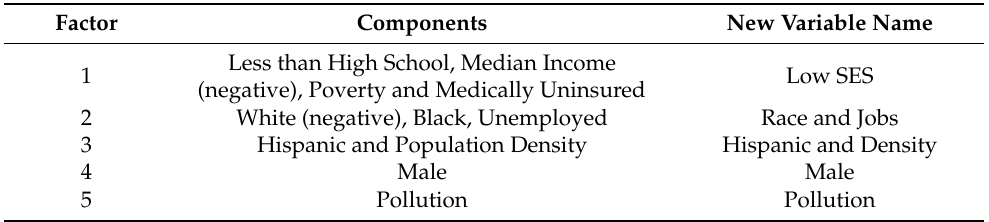
Table 2. Results from PCA and new variables name.